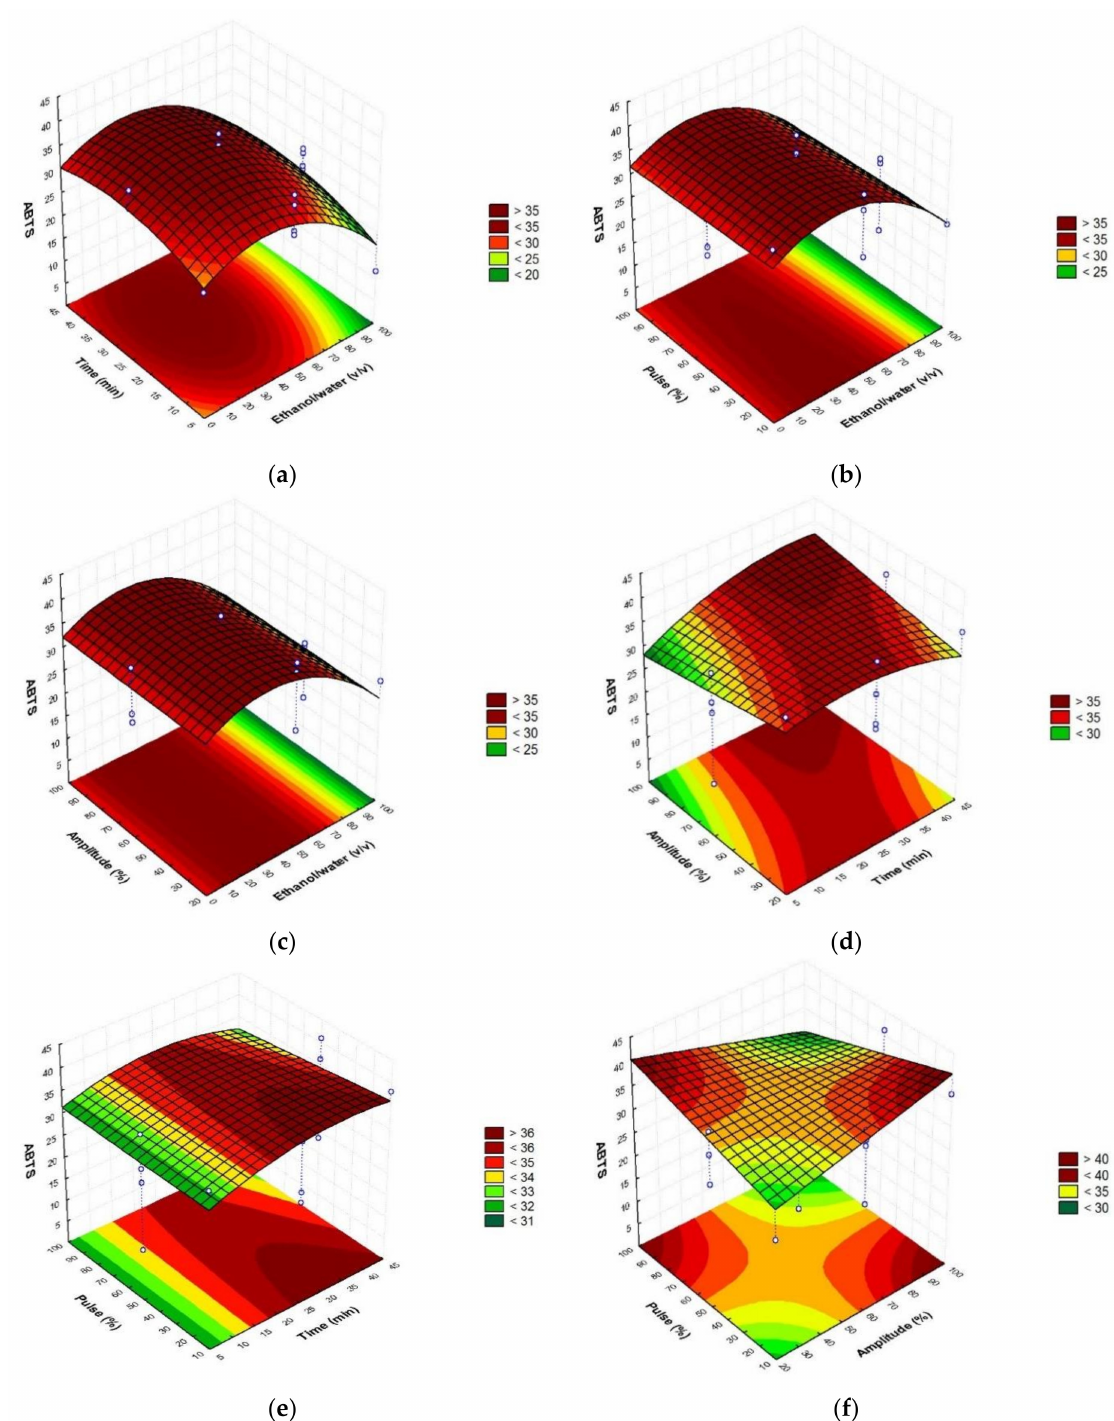
Figure 2. Response surface graphs ( a – f ) showing the combined effects of the process variables: Ethanol/water ( v / v ), time (min), amplitude (%), and pulse (%), for ABTS antioxidant assay (mg TE/g